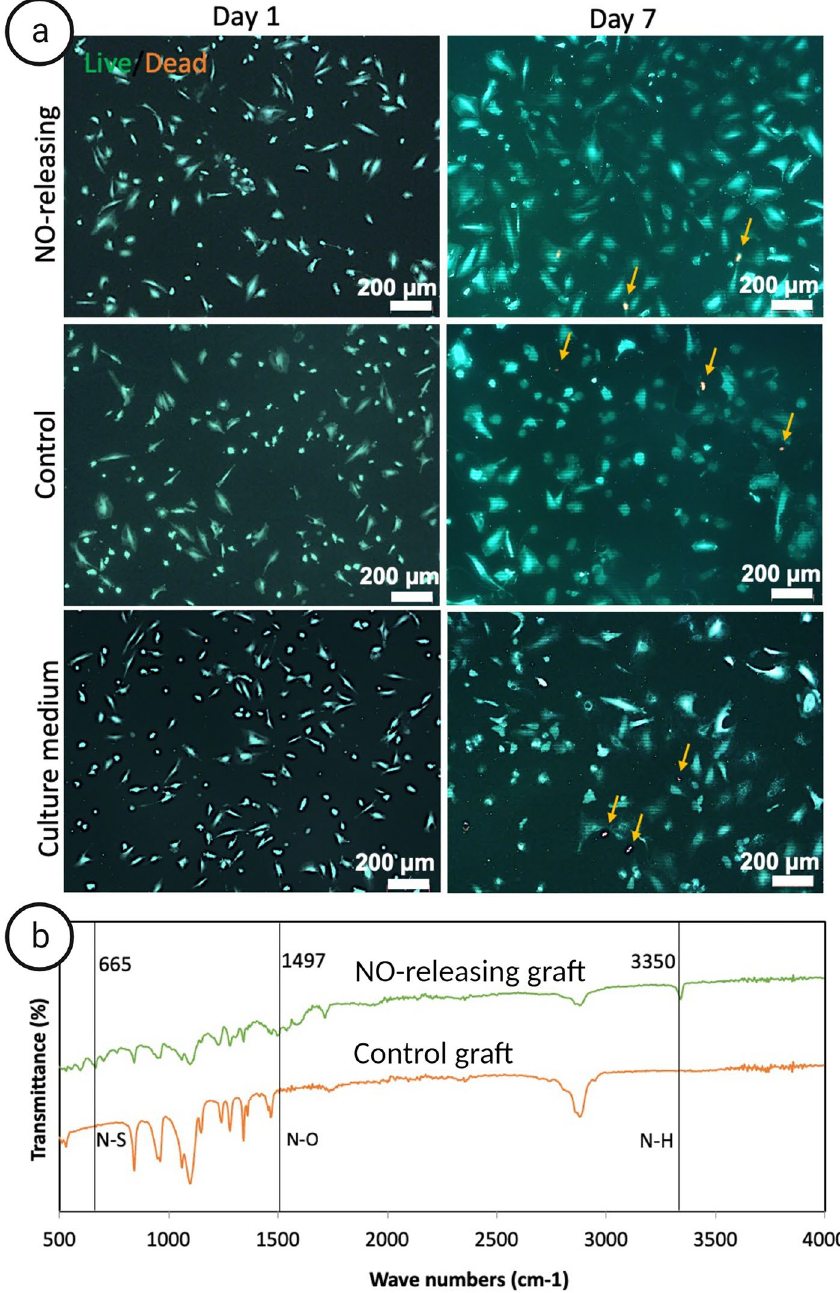
Figure 5. EC viability and characteristics of NO-releasing and control samples. ( a ) Live/dead fluorescence images of HUVECs incubated in direct contact with NO-releasing grafts, control grafts or culture medium. The upper row represents the cellular viability after 24 h and the lower row displays the viability after 3 days of incubation. Live cells are stained green by calcein-AM and dead cells in red by ethidium homodimer-1, respectively. Orange arrows indicate dead cells. ( b ) FTIR spectra of NO-releasing (10% (w/w) SNAP- matrix—10% (w/w) SNAP-MWCNTs-OH) and control samples (non-loaded matrix—non-loaded MWCNTs-OH) which used for biological experiments. Scale bar = 200